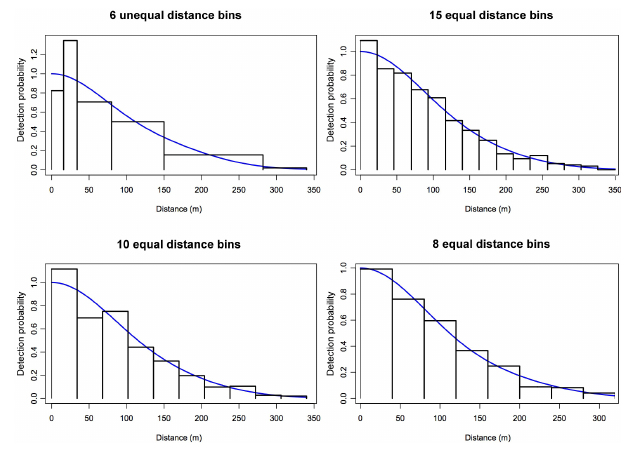
used with each (region:year) model, indicating a good overall fit (Table 1). Probability of detection estimated by each of the four chosen models was: 0.39, 0.31 in Brier 2009, 2010 and 0.32, 0.26 in Grand Manan 2009, 2010. Corresponding point estimates for density (D) and abundance (N) of phalaropes by survey date are given in Table 2. Fig. 2 . Comparison of data groupings enlisted to achieve robust model fit for the same detection function. Brier 2009 analysis set shown, i.e., distance data obtained from surveys flown in Brier, 2009. Figures show observed probability of detection in each distance class (histograms) against expected probability of detection (blue lines) estimated by the fitted model. Eight 40 m- distance bins out to 320 m achieved most optimal fit on basis of χ 2 p-value as well as visual inspection of fit at the left-edge of the detection